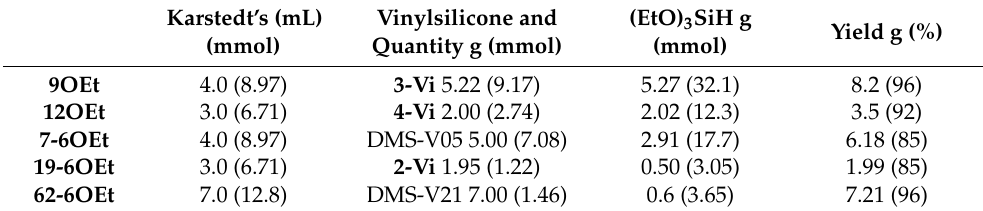
Table 2. Quantities used to prepare trialkoxysilicones from